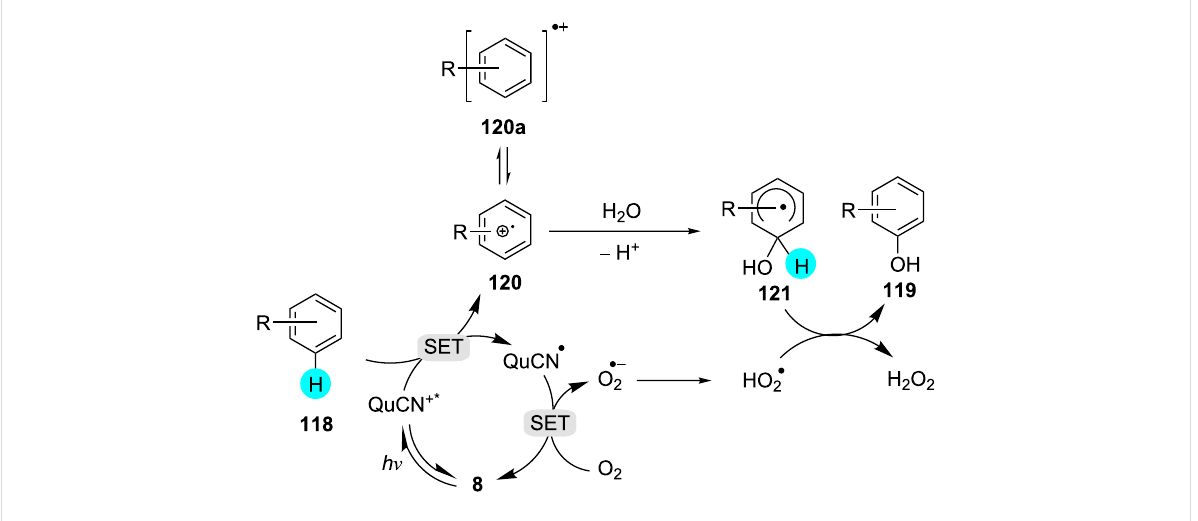
Figure 19: Mechanism for the synthesis of phenol derivatives with photoredox catalyst 8 .